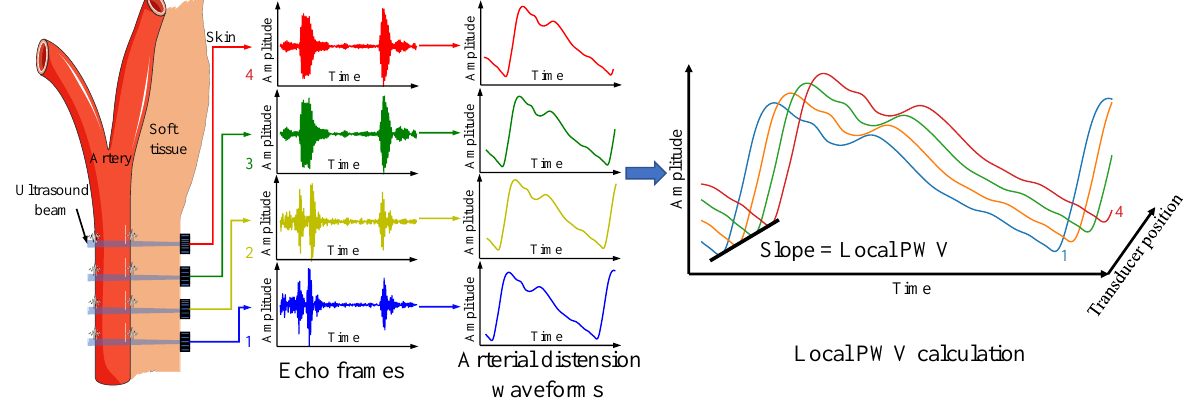
Figure 1. Local PWV measurement principle.